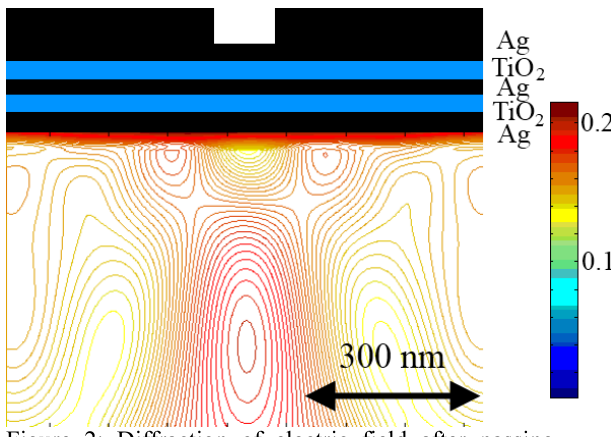
Figure 2: Diffraction of electric field after passing through hyperbolic metamaterial with flat